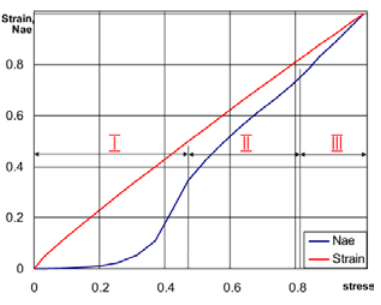
Fig. 10. Graph of the total AE change and the deformation due to the stress-strain with a longitudinal arrangement of warp fibers relative to the tensile force.